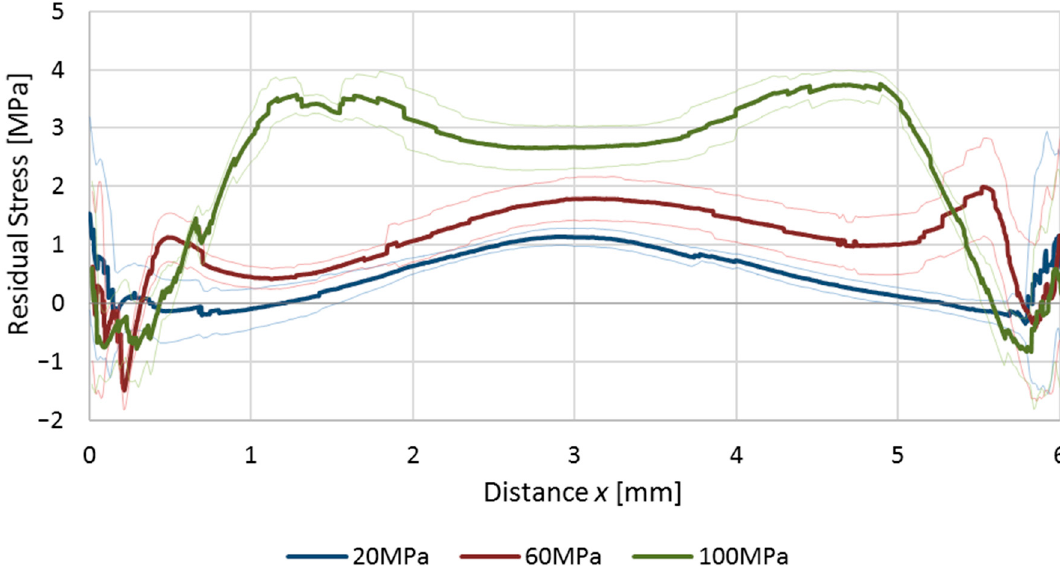
Figure 8. Residual stress curves obtained via stress whitening method for samples produced with different holding pressures ( P h ). Thin lines represent standard deviation.